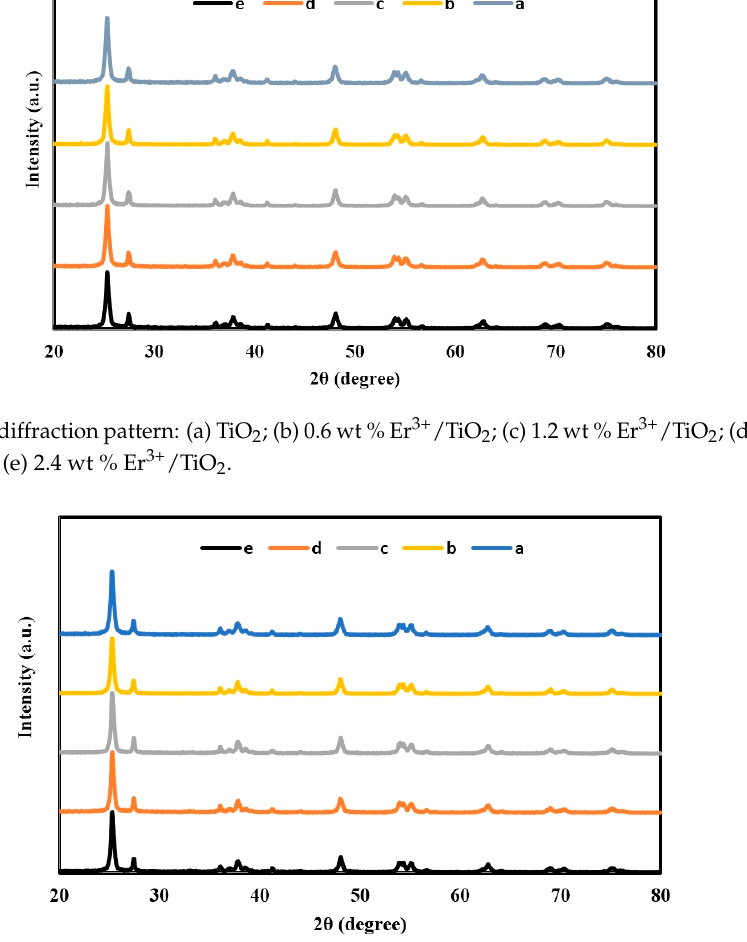
Figure 2. X-ray diffraction pattern: (a) TiO 2 ; (b) 0.2 wt % Ni 2+ /TiO 2 ; (c) 0.4 wt % Ni 2+ /TiO 2 ; (d) 0.6 wt % Ni 2+ /TiO 2 ; and (e) 0.8 wt % Ni 2+ /TiO 2 .